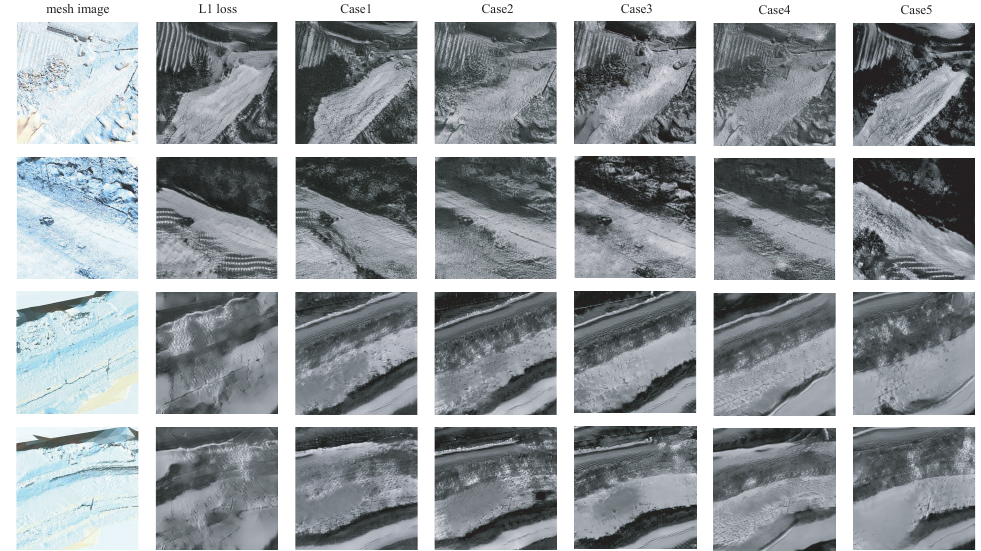
Figure 5. Constructed image comparison due to multi-window weighting parameters.